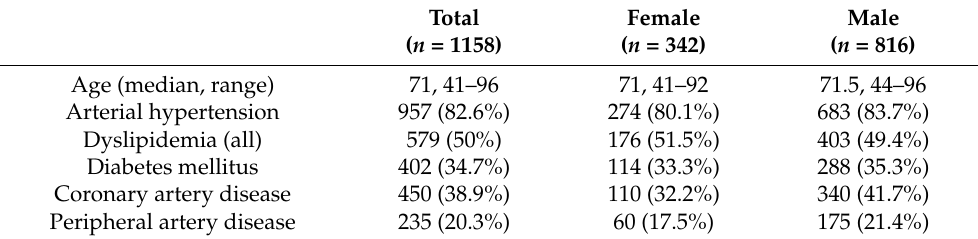
Table 3. Distribution of the risk factors among male and female